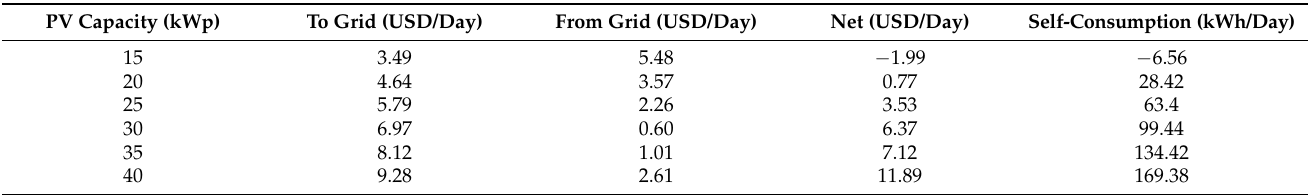
Figure 14. Sensitivity analysis with respect to PV capacity, Configuration 1. Table 4. Daily energy cost and self ‐ consumption for different PV capacities.